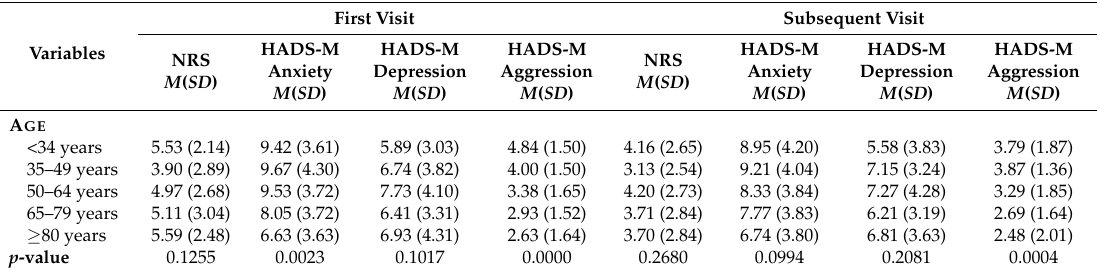
Table 4. Statistical analysis of pain intensity and emotional disturbances during the first and subsequent visit at the pain clinic depending on the age of the patients examined.